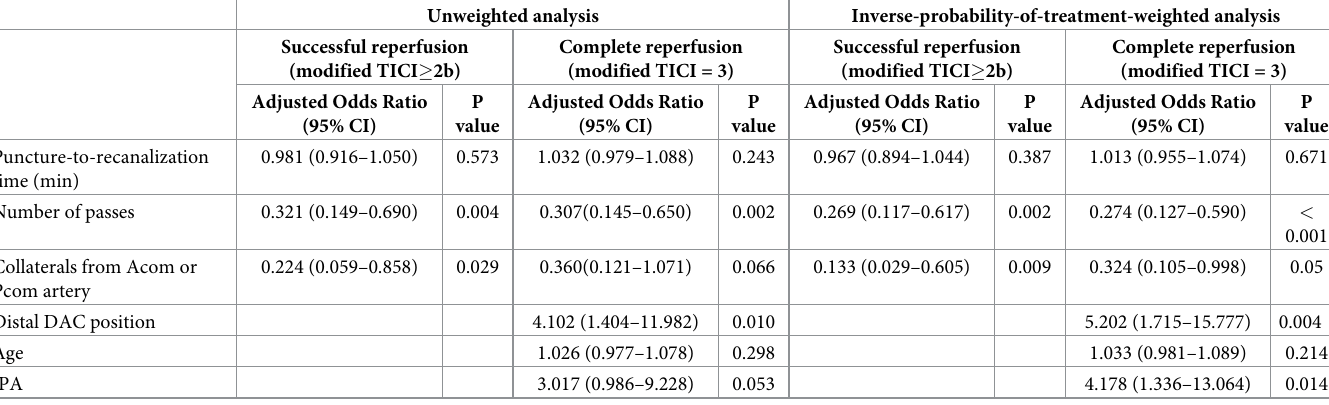
Table 3. Multivariable logistic regression analysis with dependent variables for successful reperfusion, complete reperfusion in all cases (n = 81).